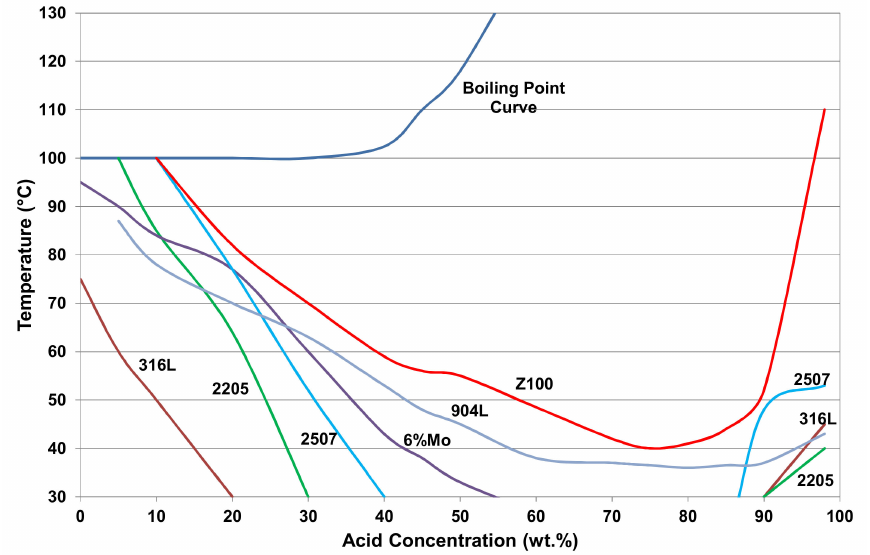
Figure 10. Iso-corrosion curves (0.1 mm/y) for some common stainless steels in sulphuric acid. Adapted from [59].